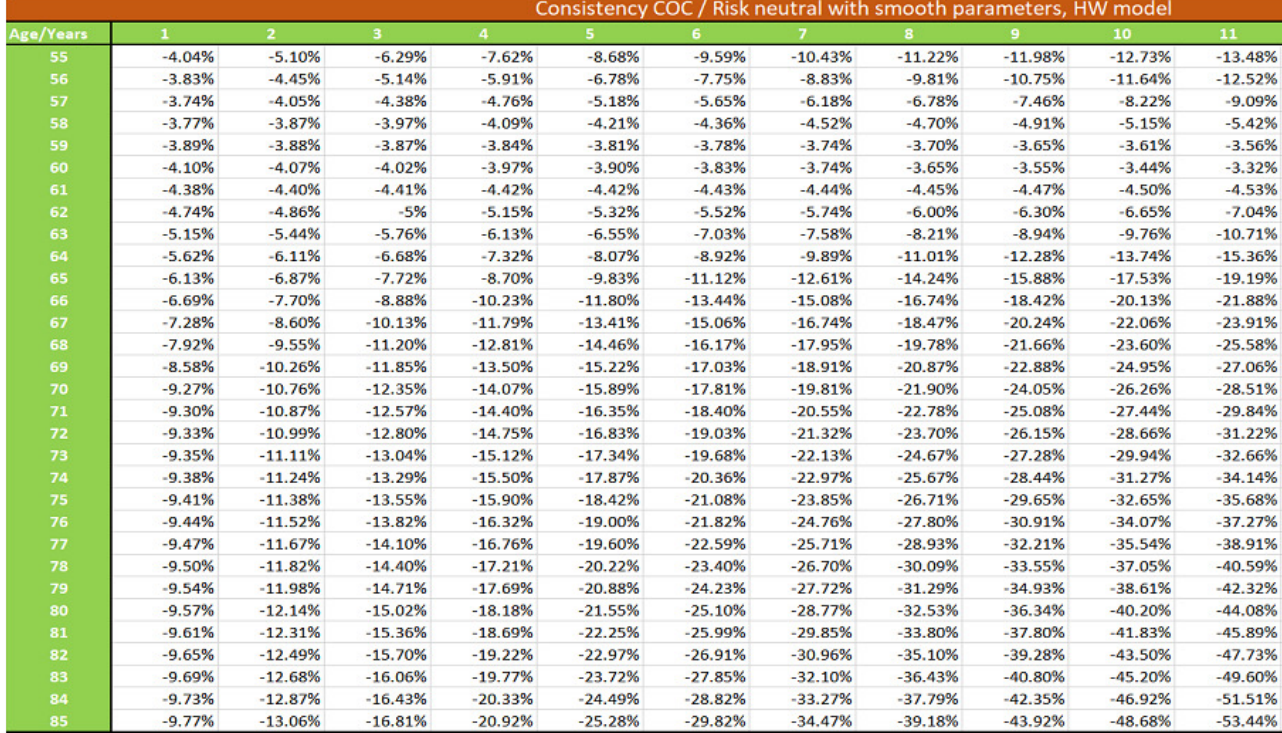
Figure A7. Consistency between risk neutral and Cost of Capital method with smooth parameters, HW